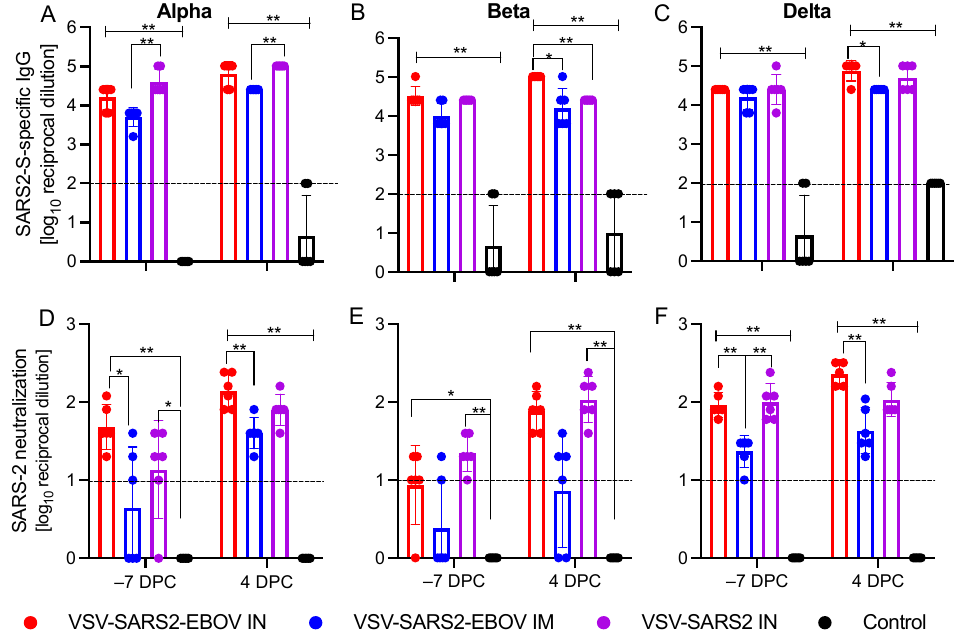
Figure 4 . Humoral responses after vaccination and challenge. Hamsters were vaccinated IM or IN with VSV-SARS2-EBOV or IN with VSV-SARS2 28 days prior to challenge with SARS-CoV-2 Alpha, Beta, and Delta VOC. At − 7 and 4 DPC serum samples were collected. ( A – C ) Levels of spike (S)-specific IgG were assessed. ( D – F ) The neutralization capacity against homologous viruses. Statistical significance as determined by the Mann–Whitney test is indicated as p < 0.01 (**) and p < 0.05 (*).